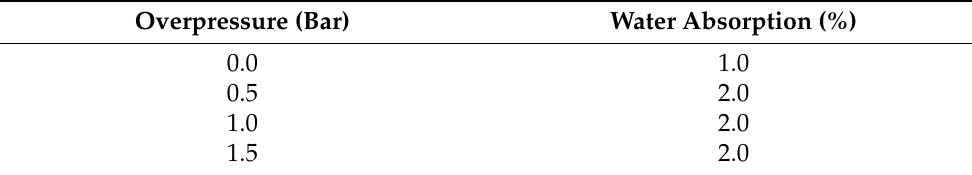
Figure 6. Overpressure water absorption test. ( a ) Test settings, ( b ) foam specimen, ( c ) pressure vessel. Table 2. Foam water absorption as a function of overpressure during 3 hours of exposure.